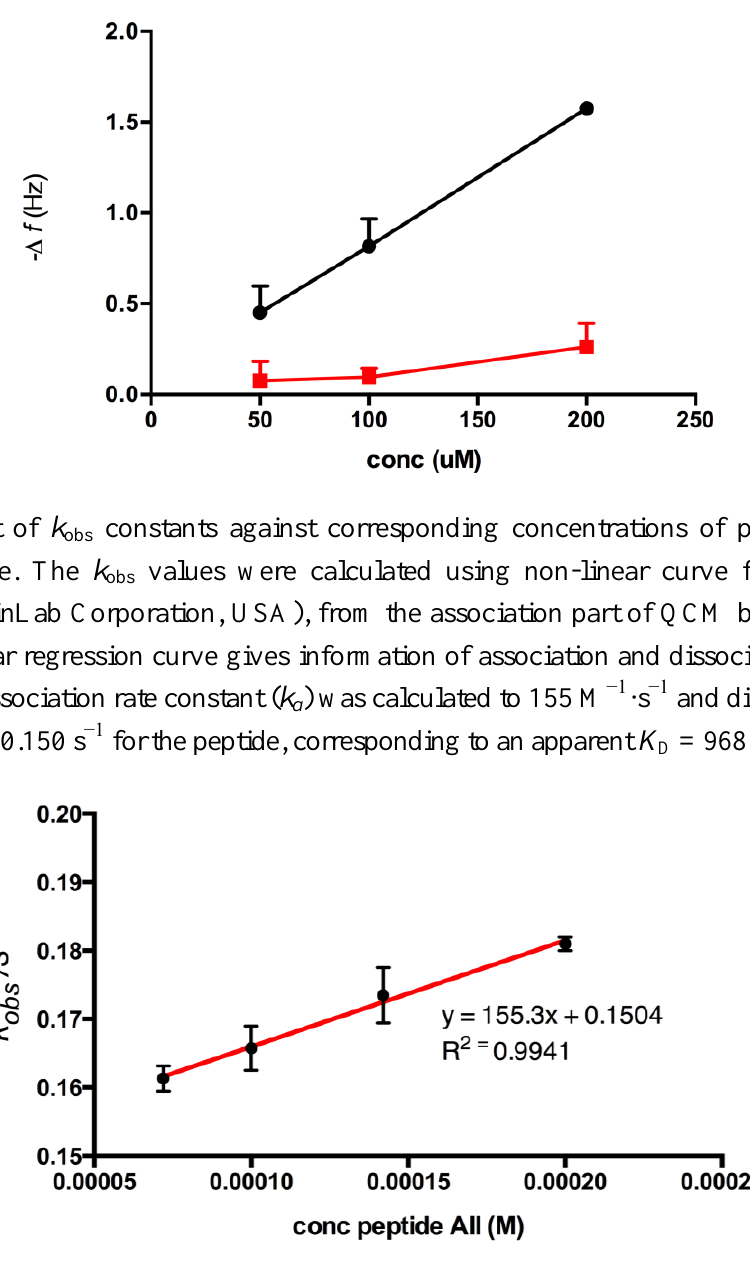
Figure 6. Maximum resonant frequency shift for Peptide AII interaction with the adenine surface (black) and carboxyl surface (red), respectively. Data from three injections of each concentration on respective resonators. Error bars represent the SEM.